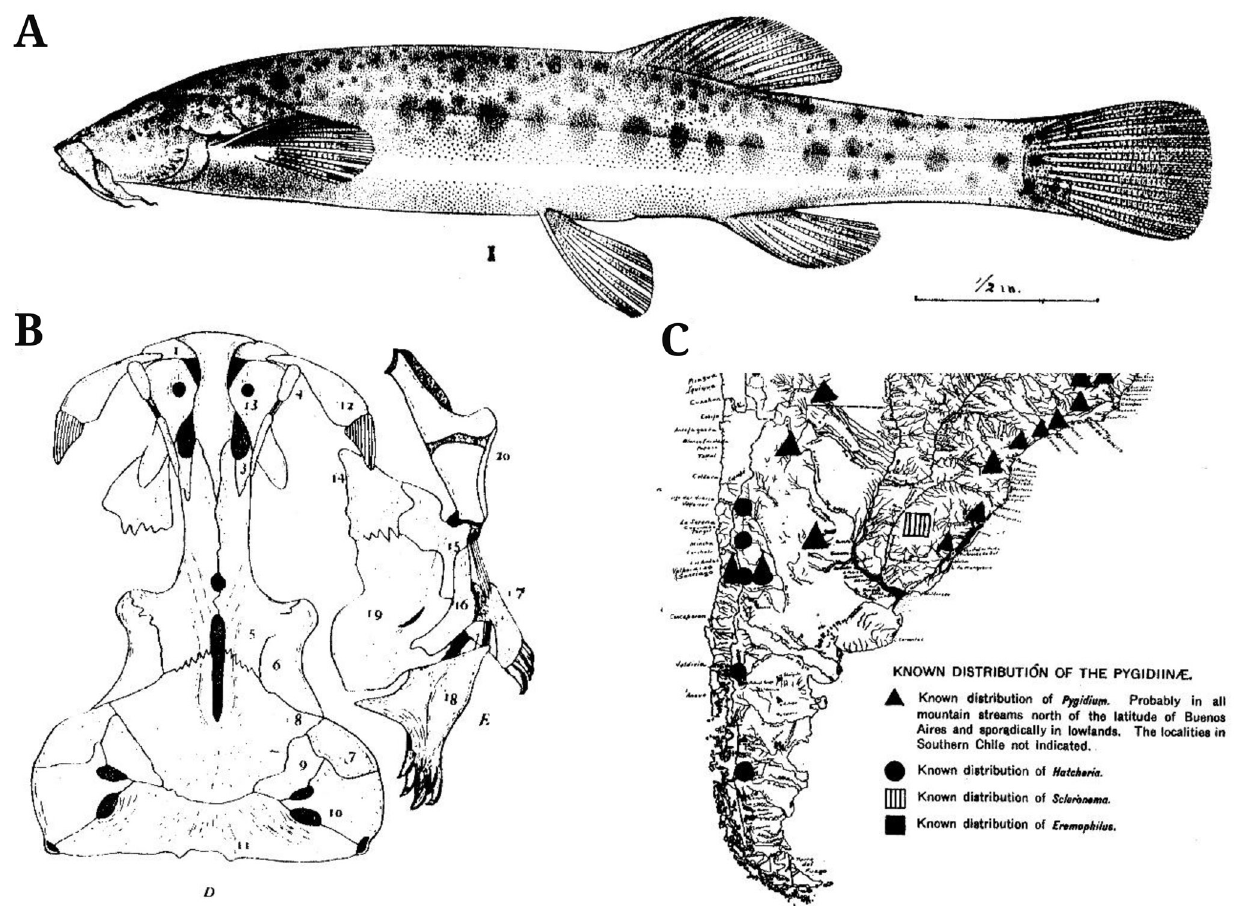
FIGURE 25 | Original drawings published by Eigenmann (1918): A. lateral view of the holotype of Scleronema operculatum , FMNH 58080, (plate 44; fig. 1); B. neurocranium, suspensorium, opercular apparatus, and inferior jaw from dorsal view of one paratype of S. operculatum , FMNH 58520, (p. 282; fig. 2d–e); C. part of the distribution map (modified from original drawing) showing the occurrence area of Scleronema (dashed square) at that time (plate